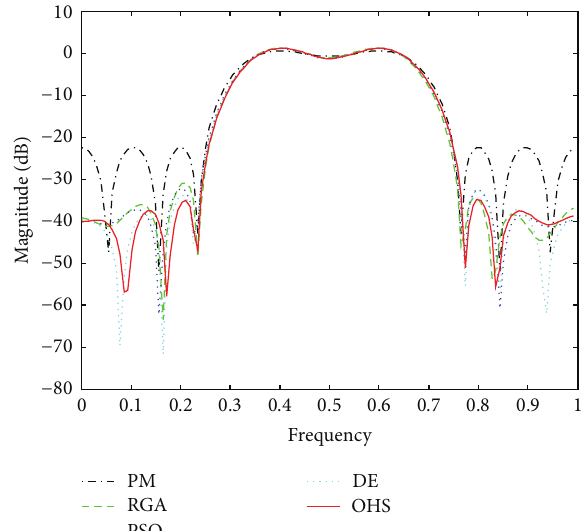
Figure 7: Normalized pass band ripple plots for the FIR HP filter of order 20.